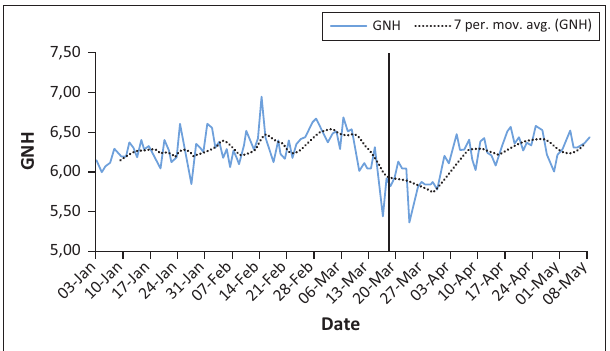
FIG URE 1: Happiness levels before and after